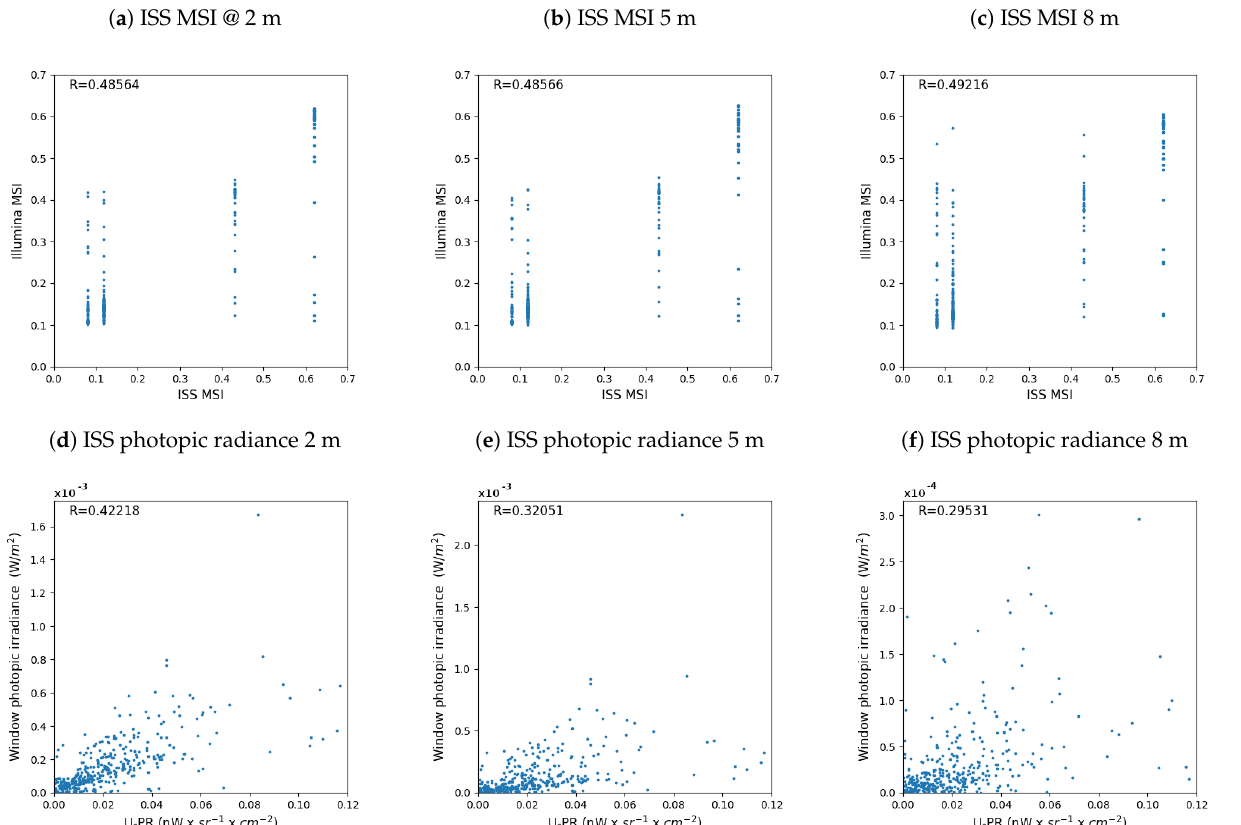
Figure 9. Scatter plots between the remotely sensed ISS MSI and MSI derived with Illumina v2 in panels ( a – c ), respectively, for window heights of 2, 5 and 8 m. Panels ( d – f ) show the scatter plots between the remotely sensed upward ISS photopic radiance and the Illumina photopic irradiance for the same set of window